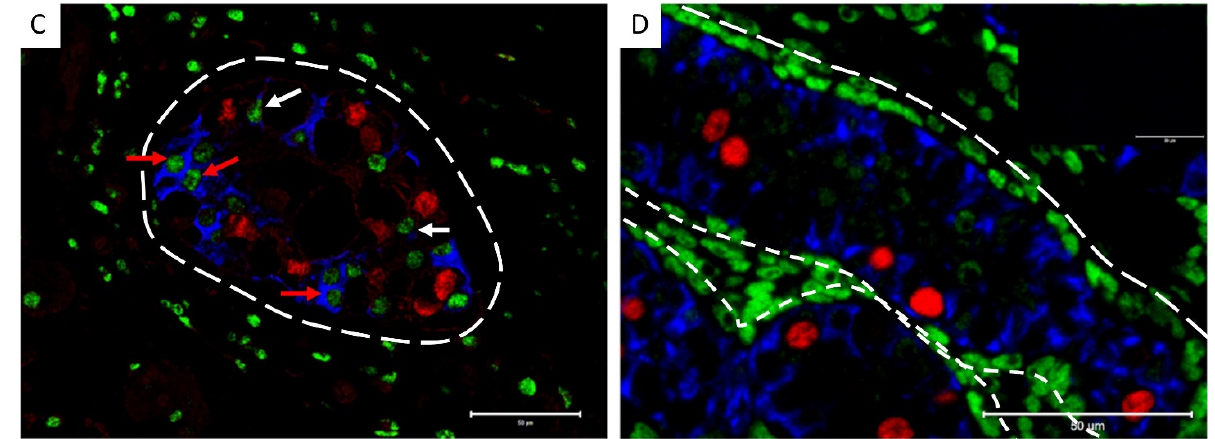
Figure 9. Cytokeratin (Blue), POU5F1 (GCNIS; red), and androgen receptor (AR, green) expression in GCNIS ‐ containing tubules from childhood ( A —7 years old, B —12 years old) and adult ( C —28 years old) patients with pre ‐ invasive TGCC. ( D ) Human fetal testis (18 GW) as a positive control for markers with negative control as inset, dashed lines represent the periphery of the seminiferous tubules. Red arrows: cytokeratin + /AR + Sertoli cells, white arrows: cytokeratin − /AR + Sertoli cells. Scale bars represent 50 μ m.